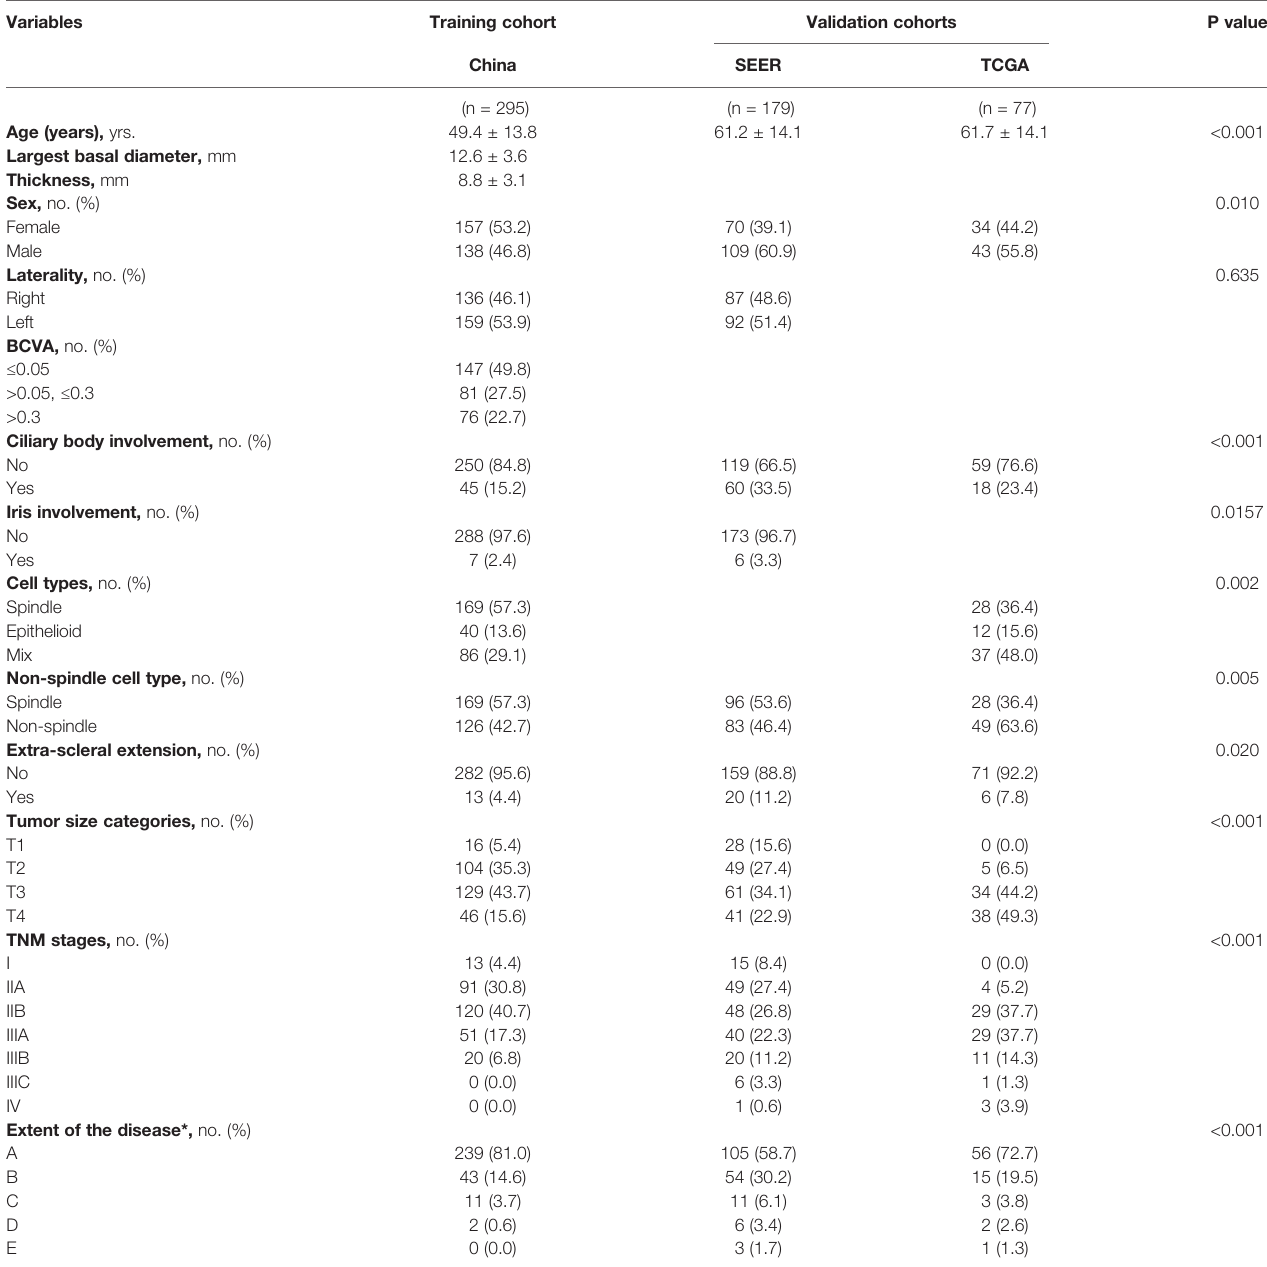
TABLE 1 | Demographics and clinicopathologic characteristics of the patients in the training cohort and the validation